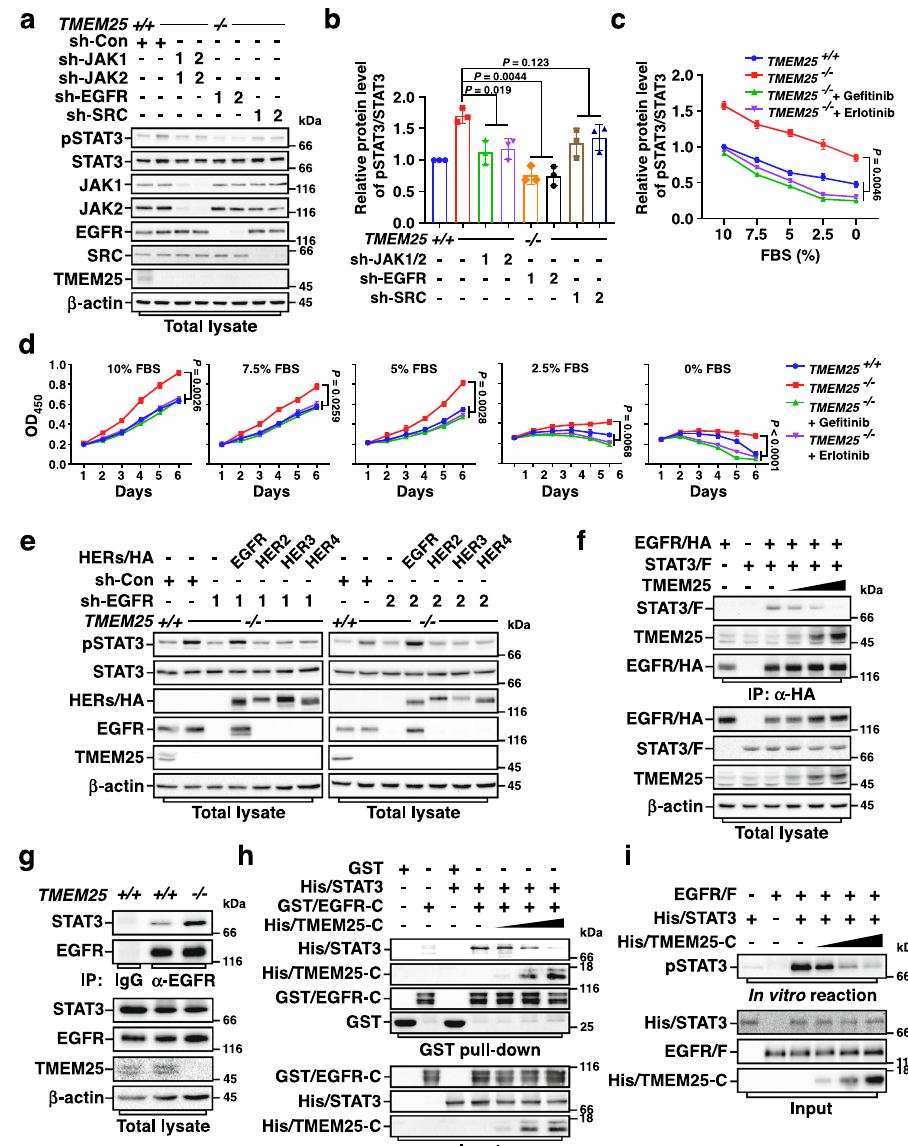
Fig. 4 | TMEM25 inhibits EGFR-mediated STAT3 phosphorylation. a , b EGFR is required for TMEM25 knockout-induced STAT3 phosphorylation. Wild-type or TMEM25 − / − MDA-MB-231 cells transduced with lentivirus encoding control shRNA (sh-Con), shRNAs against JAK1 (sh-JAK1-1/2), JAK2 (sh-JAK2-1/2), EGFR (sh-EGFR-1/2), or SRC (sh-SRC-1/2) as indicated were serum starved overnight before subjected toimmunoblotting assay( a ).RelativepSTAT3/STAT3ratios weredeterminedand plotted as mean±SEM ( n =3 individual experiments) ( b ). P values were deter- mined by one-way ANOVA followed by Tukey test. c TMEM25 knockout enhances STAT3 phosphorylation via EGFR in different serum conditions. Wild-type or TMEM25 − / − MDA-MB-231cellsgrowninindicatedFBSconcentrationsweretreated with/without EGFR inhibitor Ge fi tinib (20 μ M, 24h) or Erlotinib (20 μ M, 4h) before subjected to immunoblotting assay. Relative pSTAT3/STAT3 ratios were determined and plotted as mean±SEM ( n =3 individual experiments). P values were determined by one-way ANOVA followed by Tukey test. d TMEM25 knockout-promoted cell proliferation and survival requires EGFR activity. Cell viabilities of wild-type and TMEM25 − / − MDA-MB-231 cells cultured in indicated concentrations of FBS with/without Ge fi tinib (20 μ M) or Erlotinib (20 μ M) were